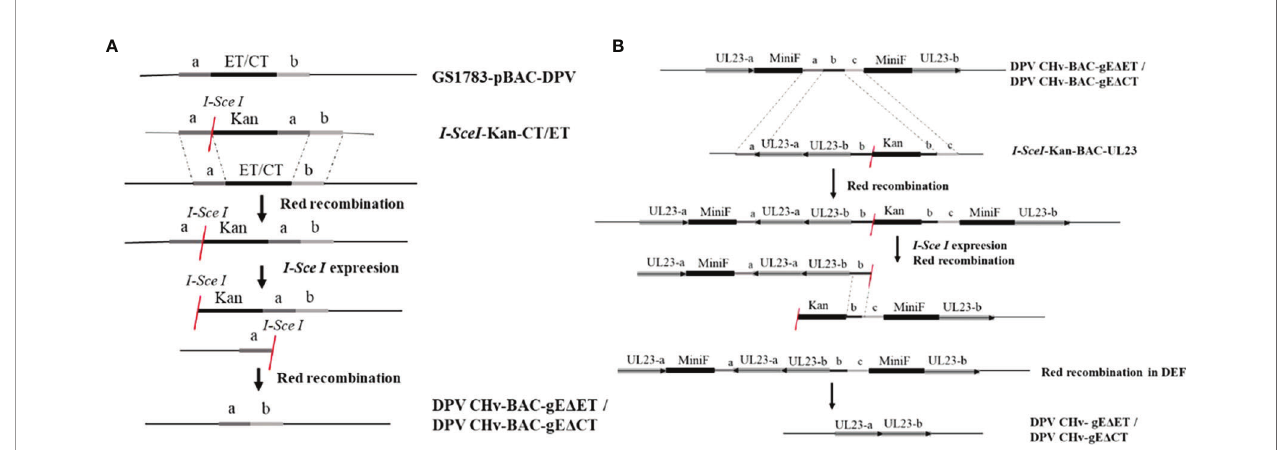
FIGURE 1 | Homologous recombination diagram. Schematic diagram of the construction of the deletion mutant virus CHv-gE D ET and CHv-gE D CT using the Red recombination system. (A) Schematic diagram of the construction of the deletion mutant virus CHv-BAC-gE D ET and CHv-BAC-E D CT using the Red recombination system. (B) Schematic diagram of the construction of the deletion mutant virus CHv-gE D ET and CHvg E D CT using the Red recombination system